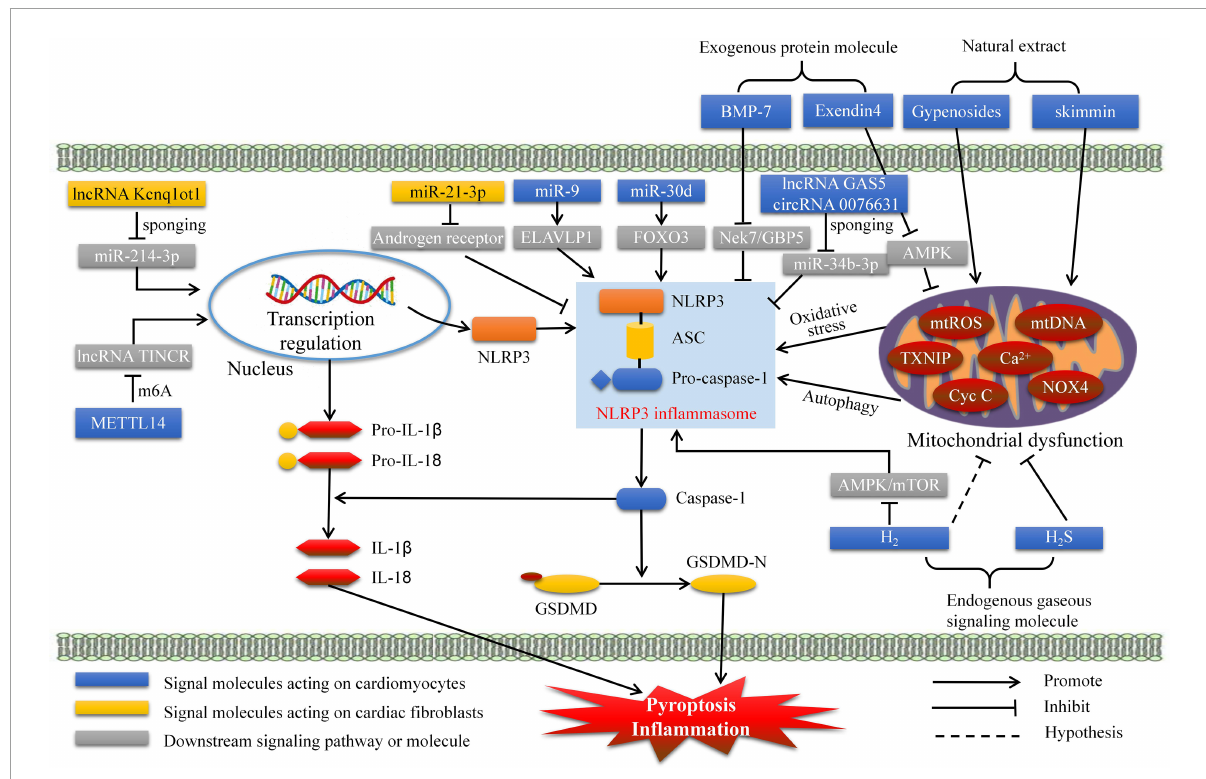
FIGURE1 Pre-clinical treatment for DCM targeting NLRP3 inflammasome mediated pyroptosis. DCM, diabetes cardiomyopathy; GSDMD, gasdermin D; H2, hydrogen; H2S, hydrogen sulfide; METTL14, methyltransferase-like 14; BMP-7, bone morphogenetic protein-7; ELAVLP1, ELAV like protein 1; mtROS, mitochondrial reactive oxygen